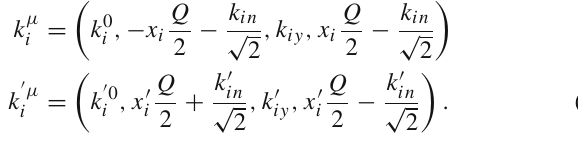
Fig. 1 Two diagrams from Compton scattering of proton in the Endpoint